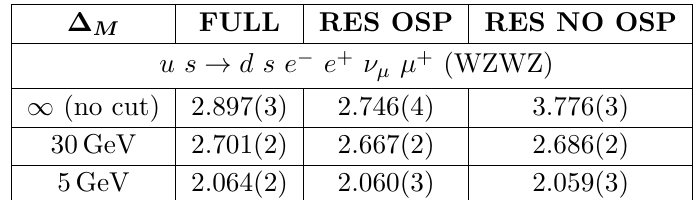
Table 8 . Cross sections ( ab ) for u s M W < (cid:1) M . All diagrams are taken into account for the full calculation (FULL), while only j double resonant diagrams contribute to the two rightmost columns, with (RES OSP) and without (RES NO OSP) projection. Selection cuts are: p j 3 : 6 ; M 4 ‘ > 300 GeV, M